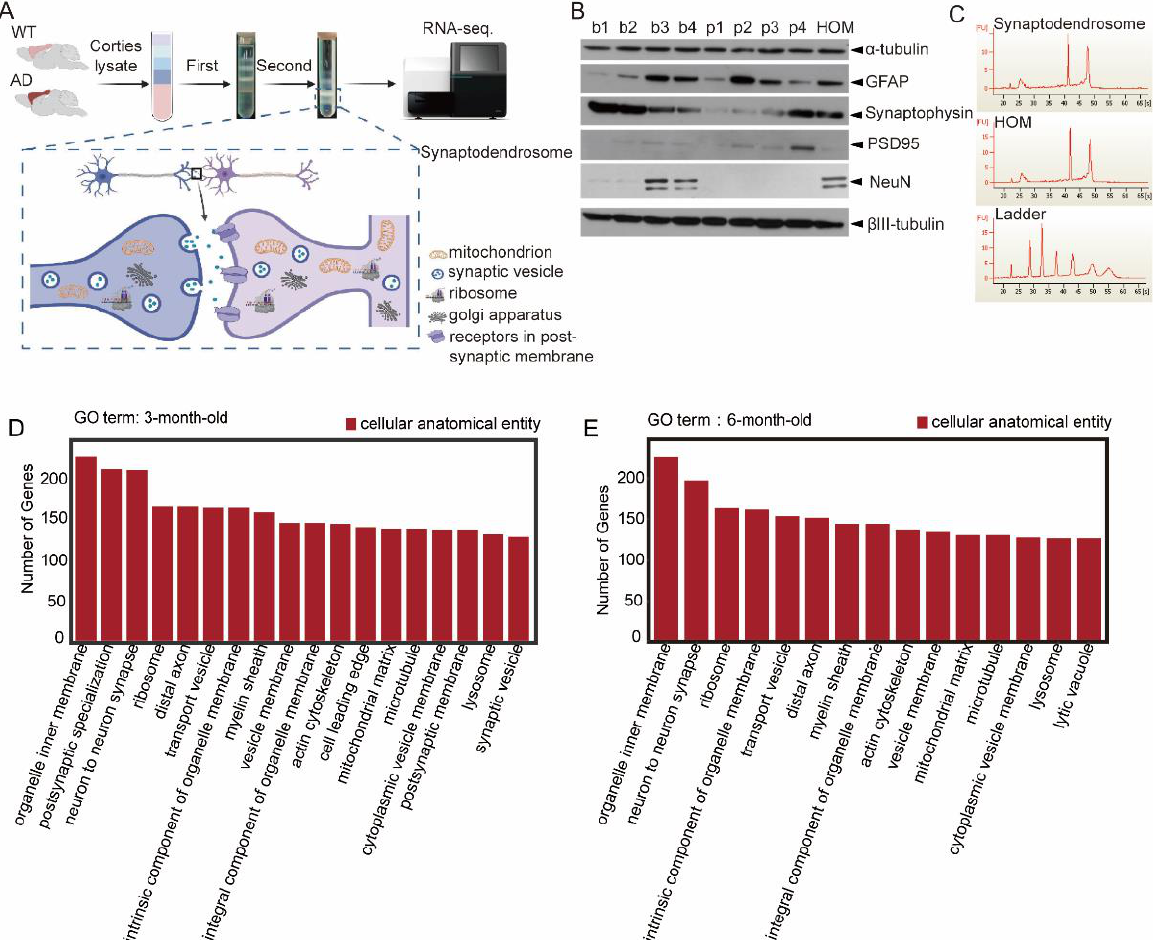
Figure 1. Synaptodendrosomes preparation and transcript identification. ( A ) Workflow of the synaptodendrosomes extraction procedure using 2-step density gradients. Cortical tissues were dissected from Alzheimer’s disease (AD) or wild-type (WT) mice at 3 or 6 months old, followed by subcellular fractionation to purify synaptodendrosomes. ( B ) Western blot analysis of all fractions generated in the preparation showed enrichment of synaptic markers (synaptophysin and PSD-95) in synaptodendrosomes fractions p3 and p4. b1 – b4: first density gradient ultracentrifugation; p1 – p4: second density gradient ultracentrifugation; HOM, homogenate. ( C ) Bioanalyzer analysis of RNA integrity in synaptodendrosomes ( n ≥ 3 animals per group). ( D ) Gene Ontology (GO) terms whose enriched gene counts >130 were plotted and categorized as “cellular anatomical entity” or “protein-containing complex.” Samples were from 3-month-old WT mice. ( E ) GO terms whose enriched gene counts >130 were plotted and categorized as “cellular anatomical entity” or “protein-containing complex.” Samples were from 6-month-old WT mice. All transcripts with an average expression level of reads numbering ≥ 10 were used for GO enrichment